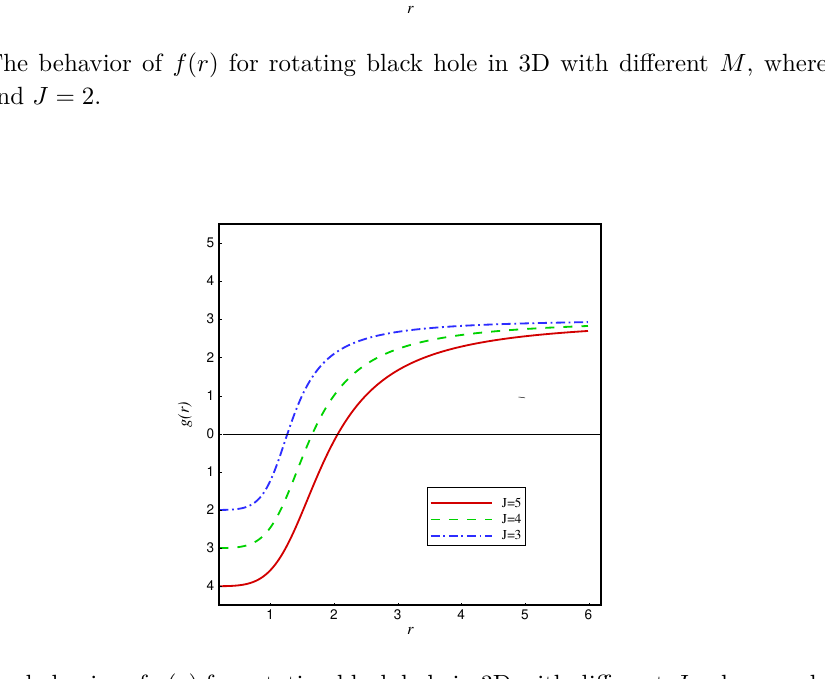
Figure 5 . The behavior of g ( r ) for rotating black hole in 3D with different J , where we have taken l = 1 , b 0 = 0 . 5 and M = 2